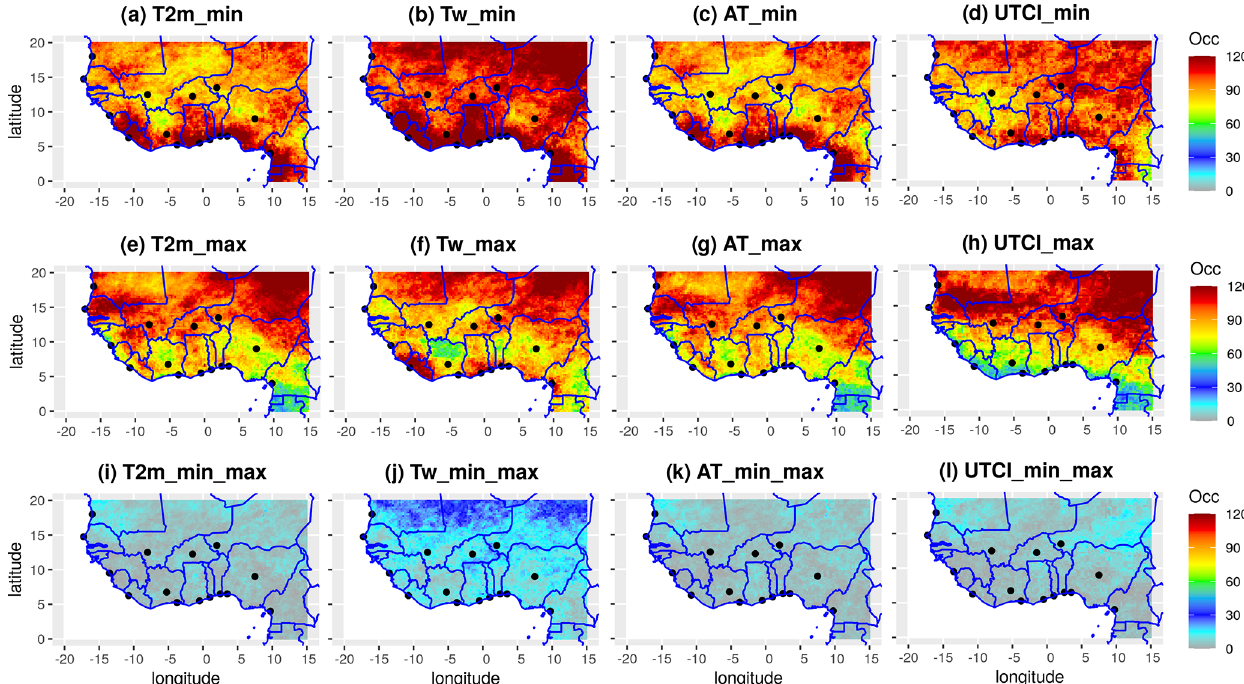
Figure 5. Climatological state of heat wave occurrence over West Africa during the period 1993–2020 using four different indicators ( T 2m , T w , AT, UTCI). The detection of heat waves is based on the definition adopted: (a–d) minimum values of indicators, (e–h) maximum values of indicators, and (i–l) minimum and maximum values of indicators. The detection of heat waves was processed using ERA5 reanalysis and the climatological daily 90th percentile over the period as a threshold. The x and y axes represent the longitude and latitude in degrees respectively. The colour bar shows the frequency of heat waves per